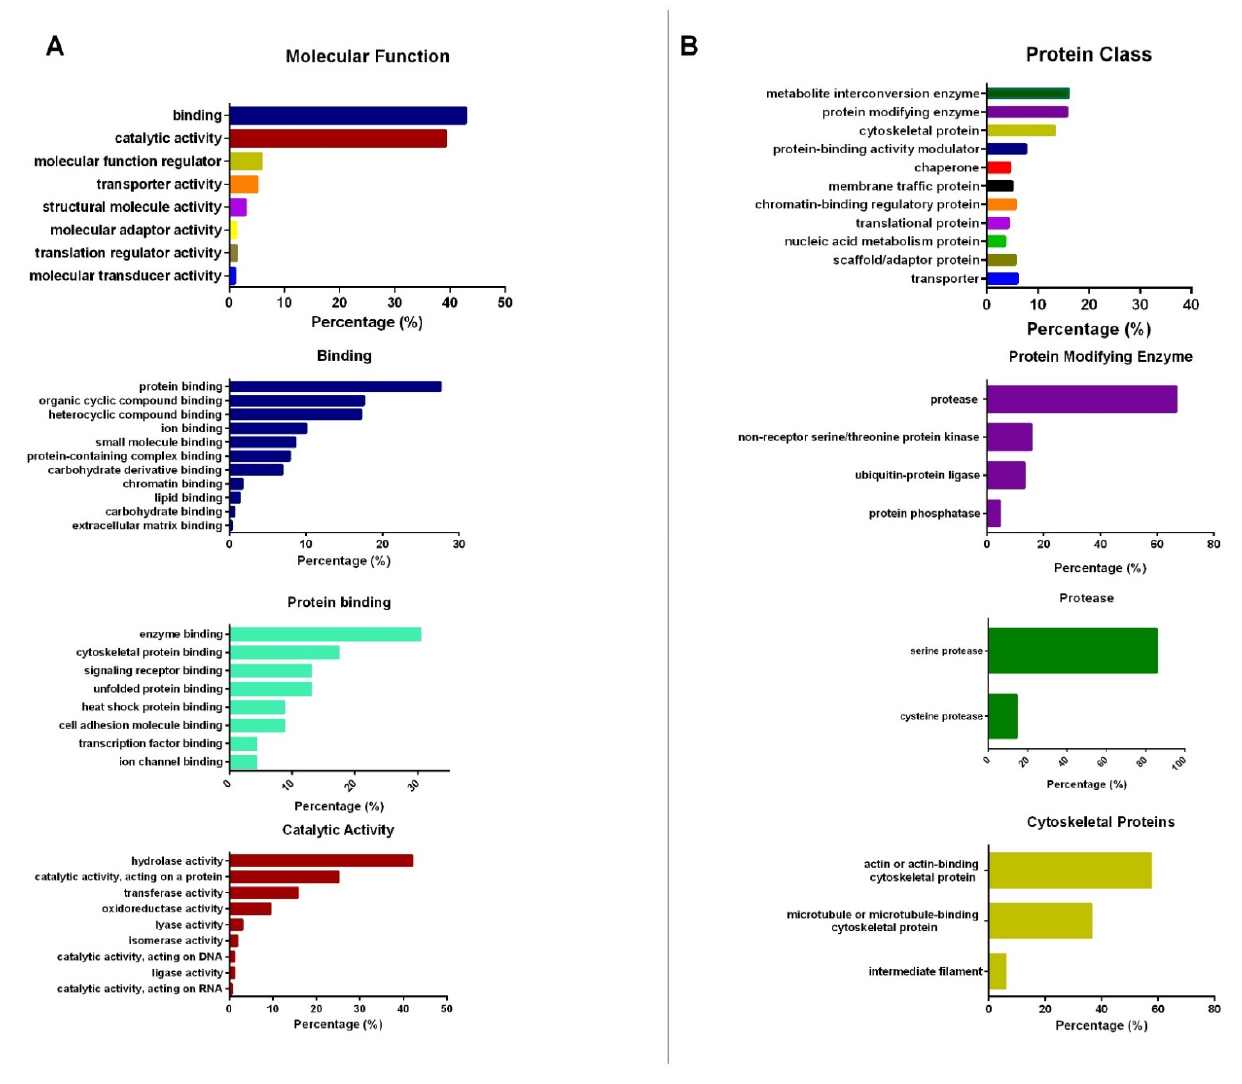
Figure 3. The categorization of proteins according to their molecular function ( A ) and protein class ( B ). The majority of the proteins are protein-modifying enzymes and cytoskeletal proteins ( B ) and have functions of binding and catalytic activity ( A ). Table 1. Proteins identified by mass spectrometric analysis. Selected proteins are in bold.